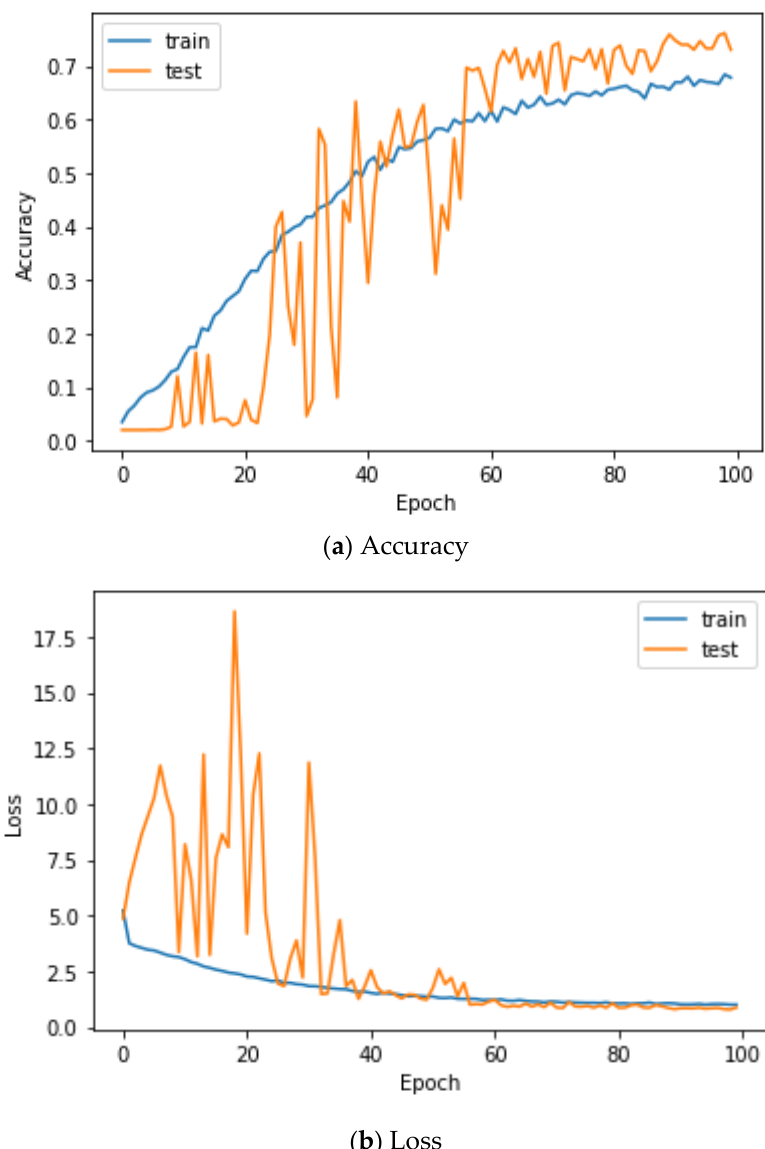
Figure 6. Training history of Case 1 on the Angeles EMG dataset.